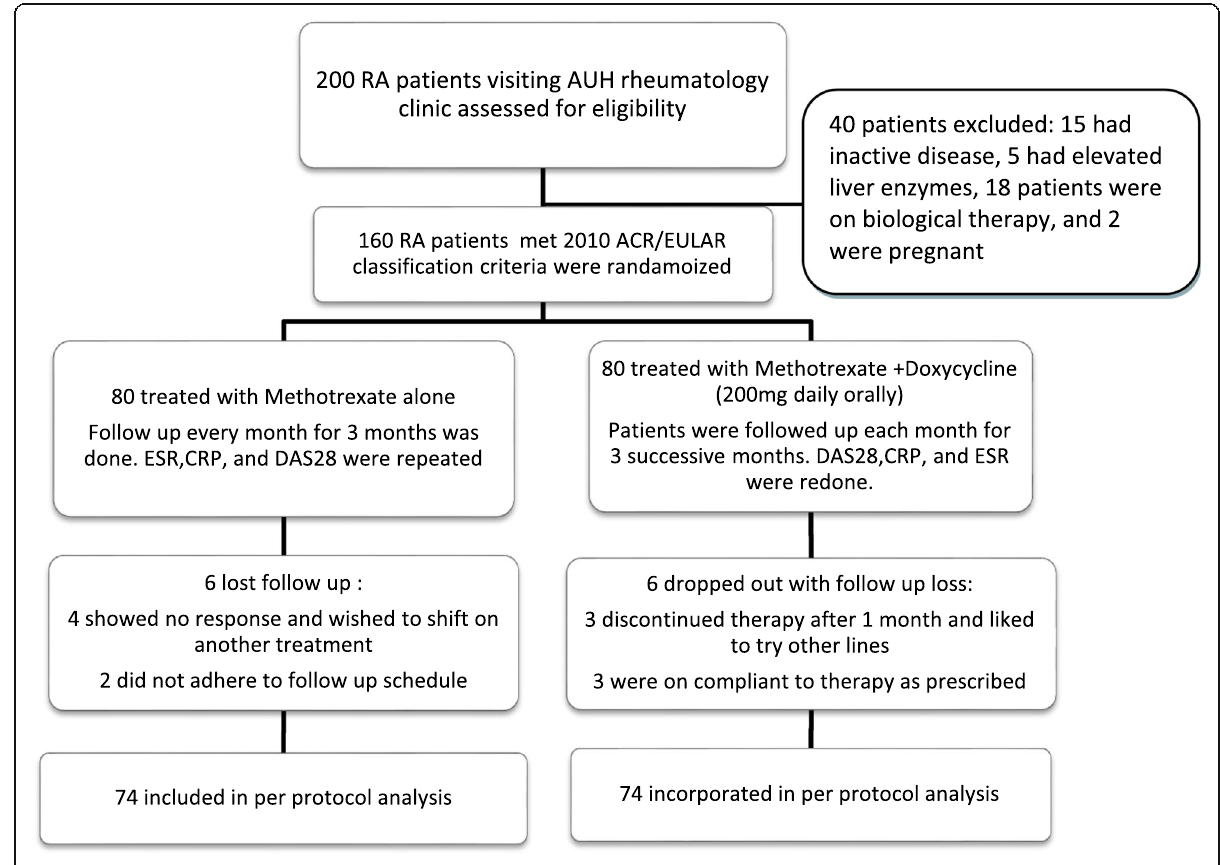
Fig. 1 CONSORT flowchart of the study